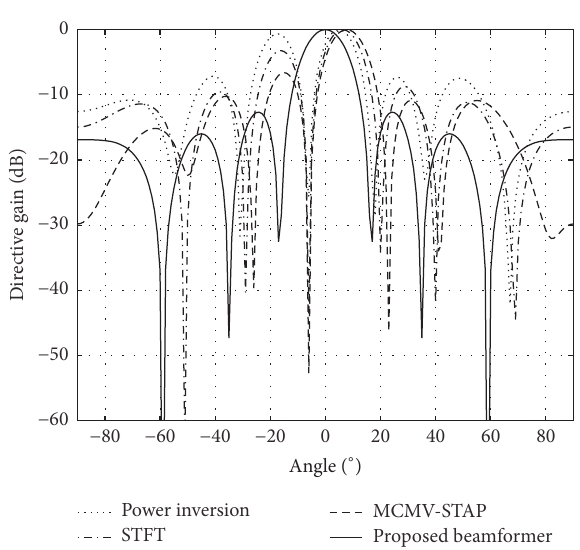
Figure 5: The array antenna pattern of antijamming for different method: the angle of arrival of the satellite signal is 0 degrees and the angle of arrival of jamming signal is − 6 degrees.